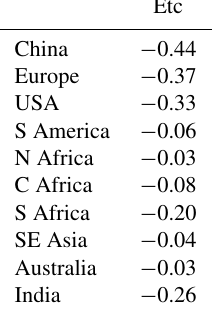
Table 7. Regional and 10-year mean correction factor for the emis- sion diurnal variability (Etc) for 2005–2014.